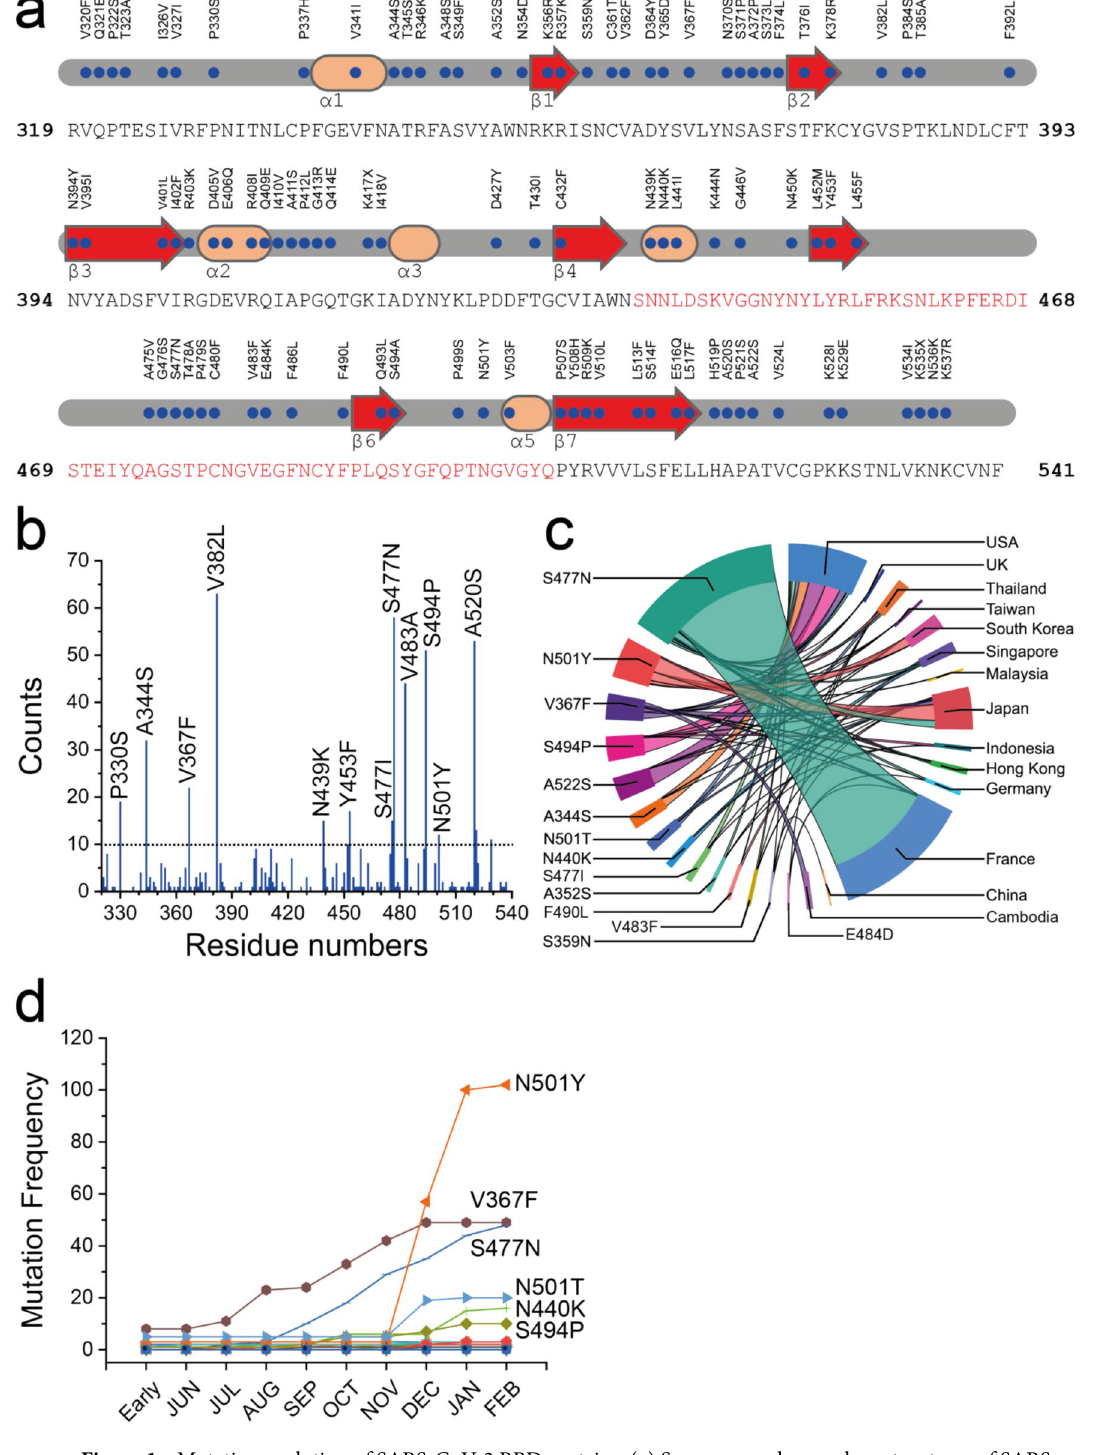
Figure 1. Mutation evolution of SARS-CoV-2 RBD proteins. ( a ) Sequence and secondary structures of SARS- CoV-2 RBD with variants in RBD region. The binding domain sequence is shown in red. ( b ) Distribution of 166 mutant types and nonsynonymous variants in RBD region and their overall mutation counts. All positions containing gaps and missing data were eliminated. ( c ) Chord diagrams representing the correlations between countries and RBD variants, circularly arranged sectors represent RBD mutants and countries. Associations are indicated by intersecting chords. The diagram was created by using Power BI (Microsoft). ( d ) The time evolution of 27 SARS-CoV-2 S protein RBD mutations. Many mutations overlap their trajectories. Here, the collection date of each genome sequence that deposited in GISAID is